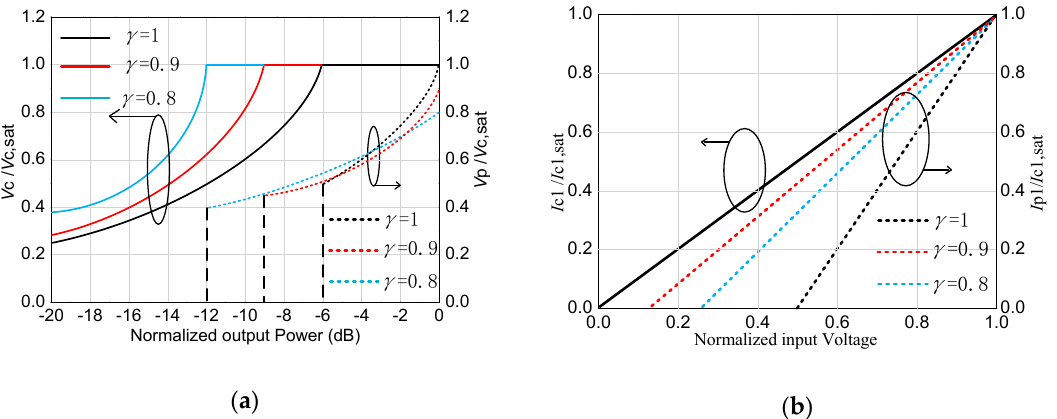
Figure 5. Voltage and current of the carrier power amplifier (PA) and peak PA: ( a ) Voltage, and ( b ) Current.